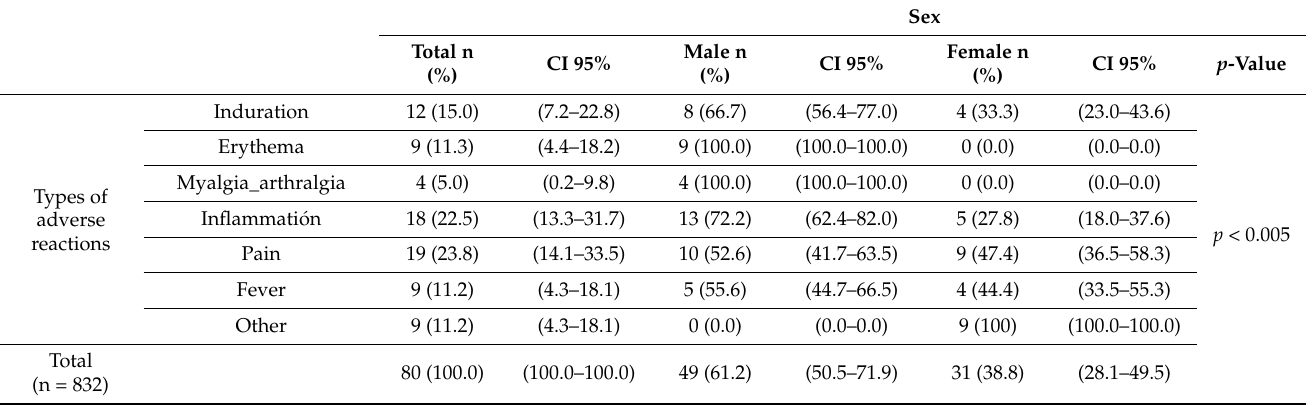
Table 4. Types of adverse